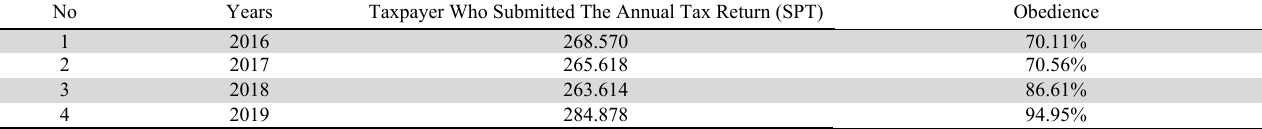
Individual Taxpayer Compliance Levels at KPP Pratama All Bali,